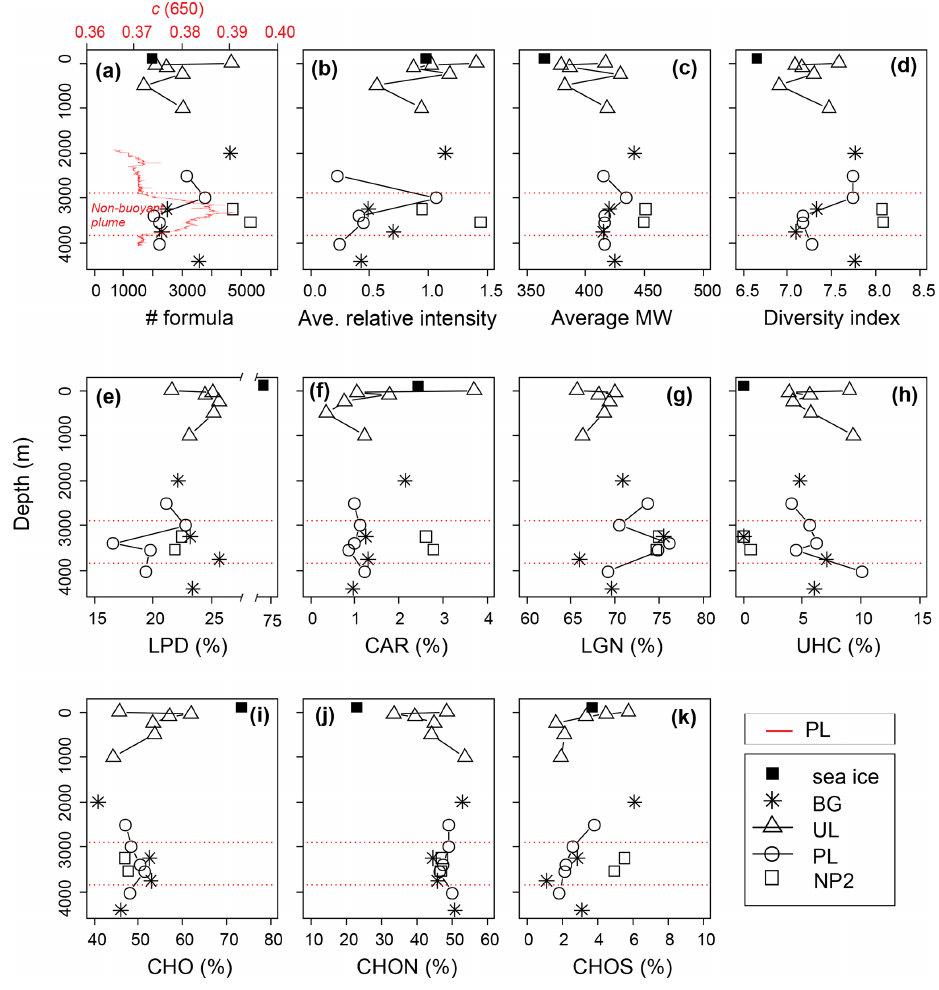
Figure 6. Depth profiles of the dissolved organic matter (DOM) composition, (a–d) molecular indices, (e–h) percentages of number of formulas in biochemical compound groups defined by H : C and O : C ratios, and (i–k) heteroatomic content in background (BG), upper layer (UL), plume (PL) and non-plume (NP2) stations. Abbreviations are MW, molecular weight; LPD, lipid- and protein-like; CAR, carbohydrate- like; LGN, lignin- and tannin-like; UHC, unsaturated hydrocarbon- and condensed aromatic-like; O : C, oxygen-to-carbon ratio; and H : C, hydrogen-to-carbon ratio. The beam attenuation profile of PL is added to the first panel to indicate the non-buoyant plume layer, and corresponding boundaries of the plume layer are indicated by red dashed lines in all